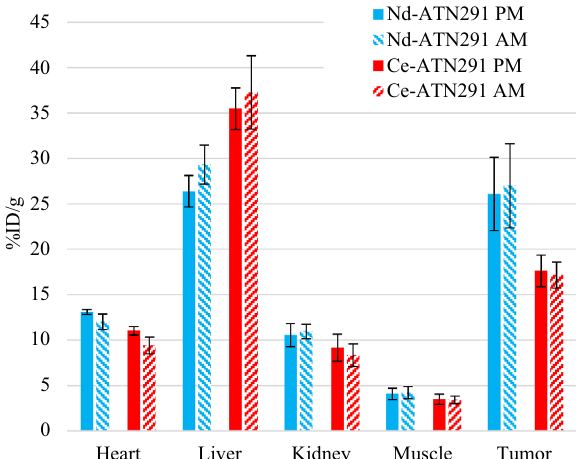
Figure 3. Quantifications for the 5-day AM (daughter) and PM (parent) PET scans for 134 Ce-cDTPA-ATN-291, and 140 Nd-cDTPA-ATN-291 in U87 MG tumor bearing mice. The “heart” ROI in the PET scans is representative of the blood pool. N = 5 in all cases, and the error bars represent the inter-subject standard deviation.